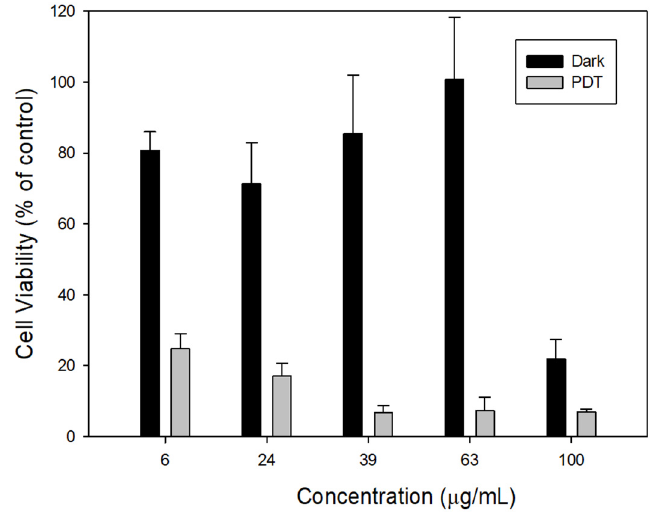
Figure 9. The cell viability of MES-SA/Dx5 cells treated with different concentrations of IBN-1-Cur- CP nanoformulation in the presence and absence of a light source.